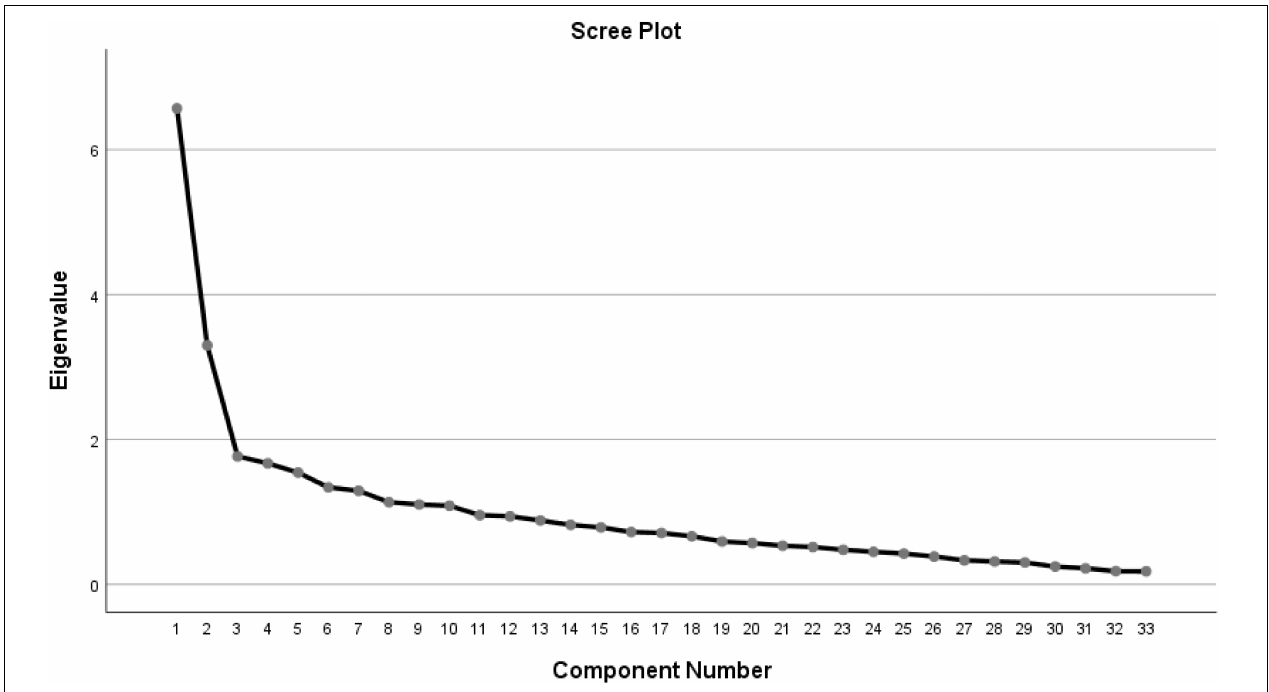
FIGURE 1 | Scree plot for the